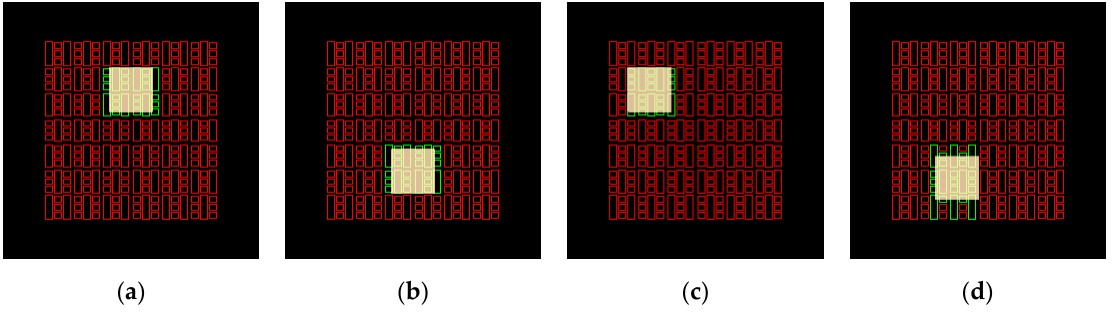
Figure A1. E-pattern omniwheeled cellular conveyor (EOCC) platform prior to the step response study mentioned in Section 2 of this paper, with starting location of ( a ) (128 px, 88 px), ( b ) (128 px, 168 px), ( c ) (82 px, 87 px), and ( d ) (107 px, 173 px).